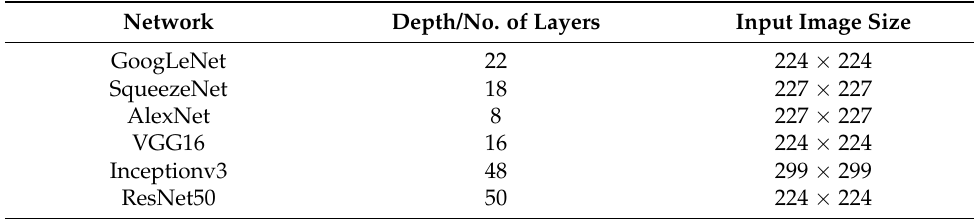
Table 5. Characteristics of the benchmark CNN models.